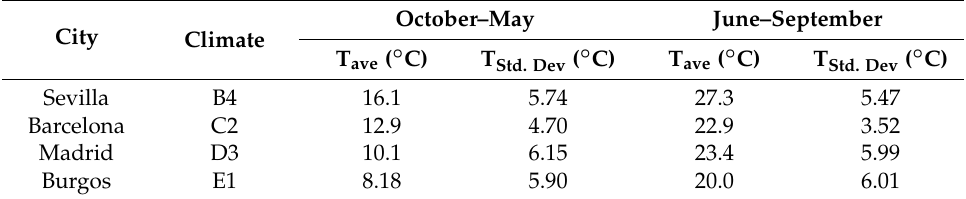
Table 1. Average and standard deviation of temperature and humidity ratio (June–September).